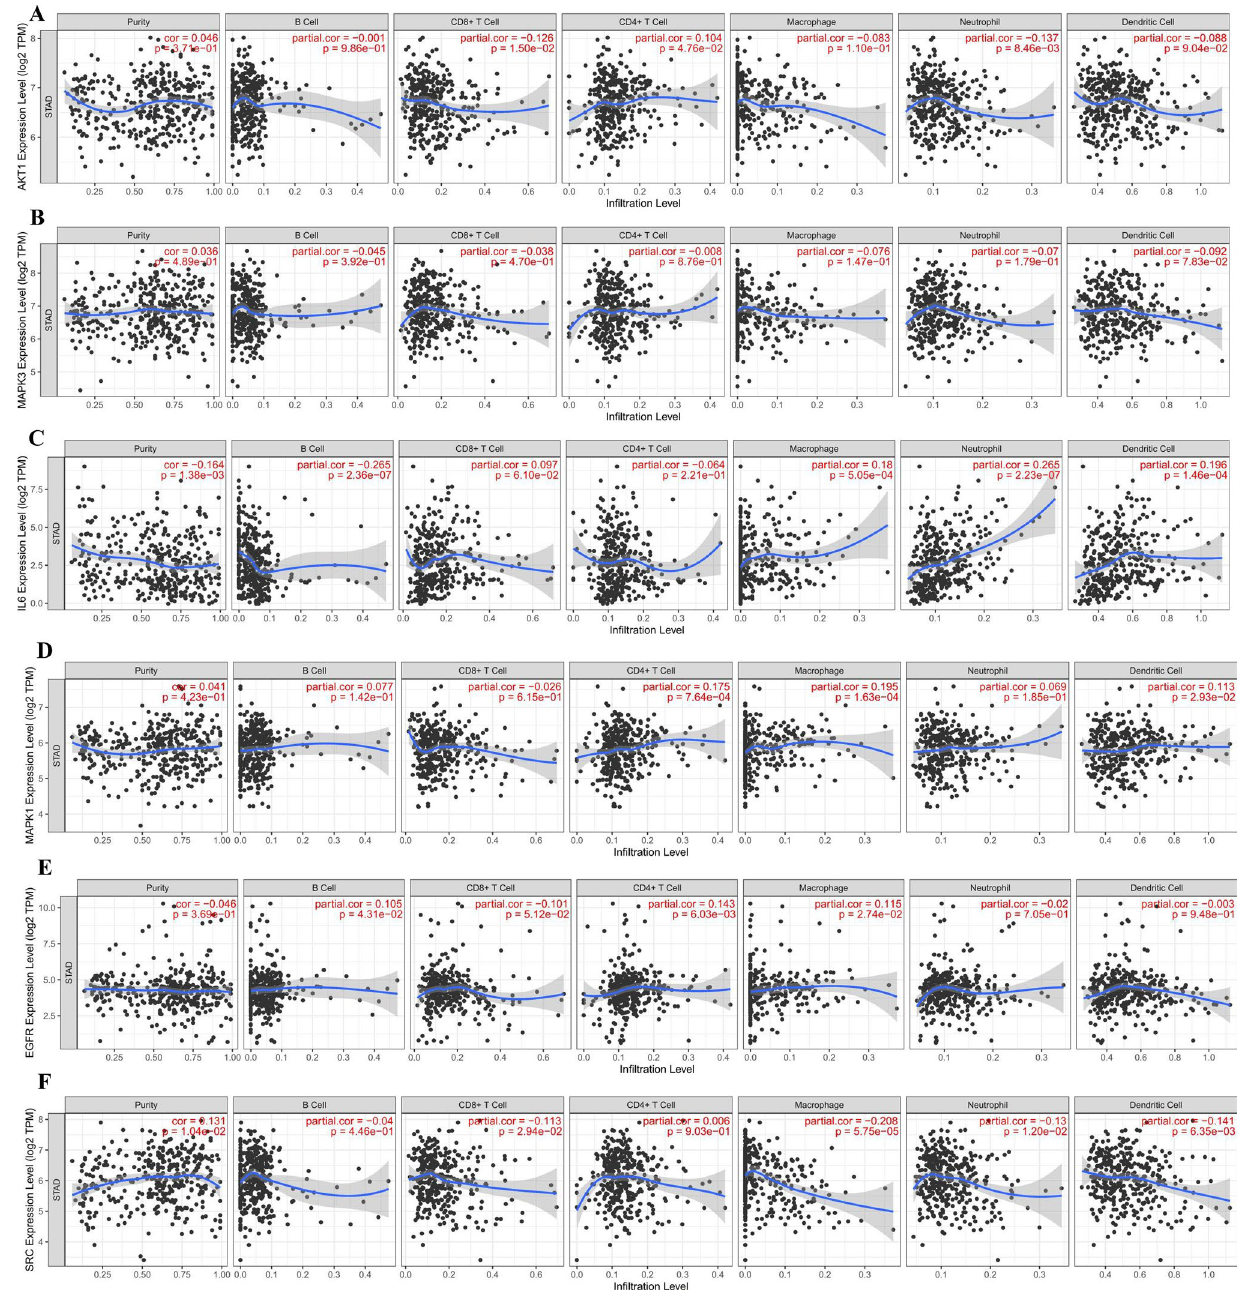
Figure 14. Correlation analysis of hub targets and immune cell infiltration. Correlation analysis of immune cell infiltration and ( A ) AKT1, ( B) MAPK3, ( C ) IL6, ( D ) MAPK1, ( E ) EGFR, ( F ) SRC, ( G ) TNF, ( H ) CASP3, and ( I ) APP in the TIMER